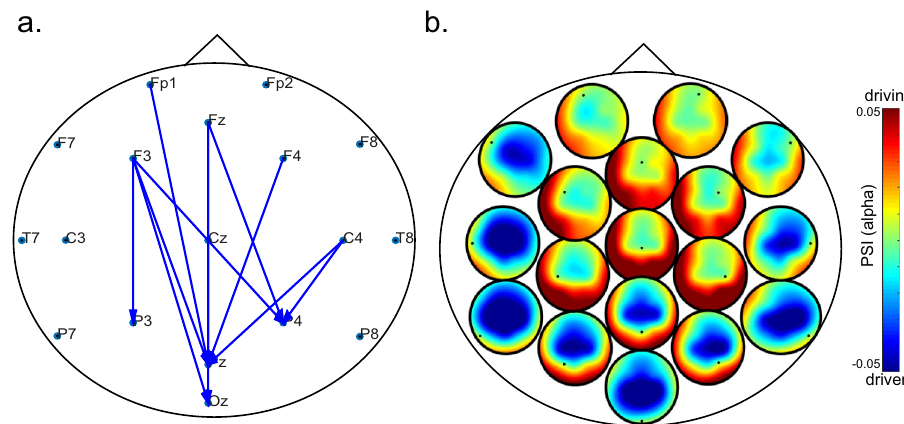
Fig. 6 Directed phase synchronization intrabrain clusters during eye contact in the alpha band. a The arrows show the signi fi cant connections for the cluster observed in the alpha band during eye contact compared to the control task (eye contact > control). b Heads-in-head plot showing the distribution of the PSI across the scalp for all electrodes. Each subtopography plot displays how the electrode represented as a dot (labels on a ) relates to the rest of the scalp. For example, the central midline electrode (Cz) appears as the driver of the alpha phase of the posterior electrodes. Overall, there is a pattern of frontal regions driving posterior areas, which were higher during eye contact compared to control ( a